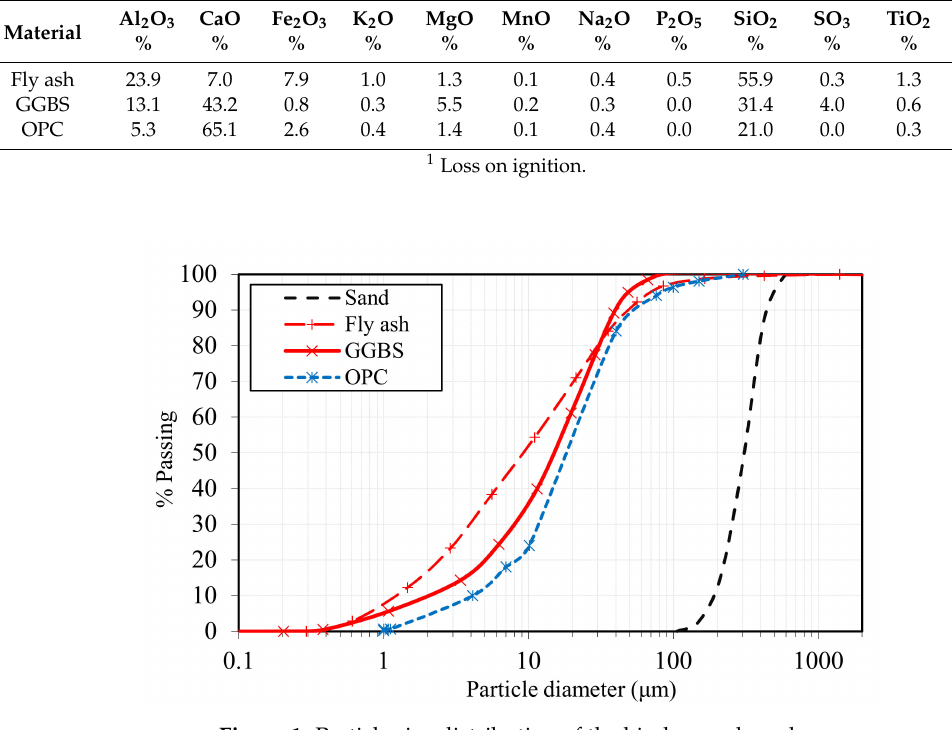
Figure 1. Particle size distribution of the binders and